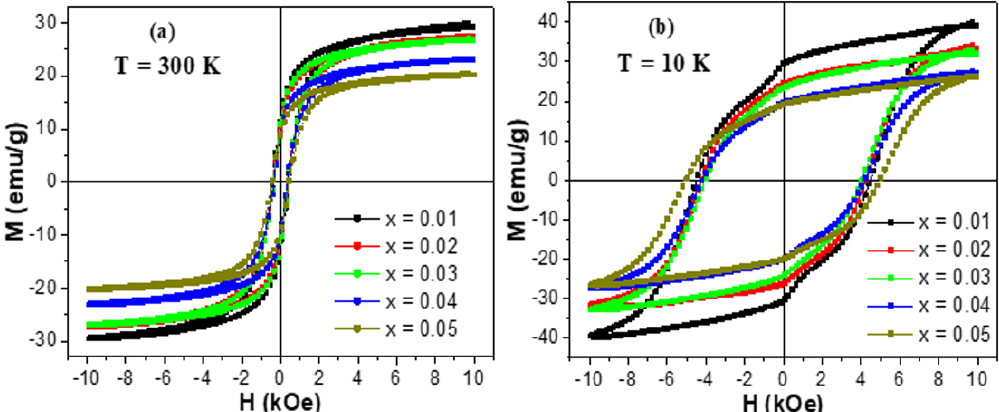
Figure 6. M-H hysteresis loops of (Co 0.5 Ni 0.5 )[Tm x Tb x Fe 2−x ]O 4 NSFs with x = 0.01–0.05 performed at: ( a ) T = 300 K and ( b ) T = 10 K.